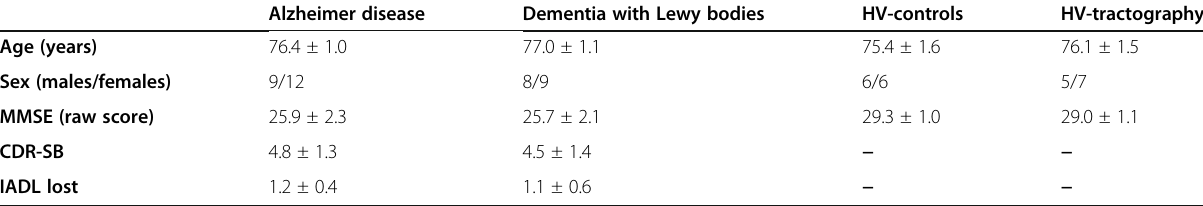
Table 1 Demographic and neuropsychological features of patients and controls Alzheimer